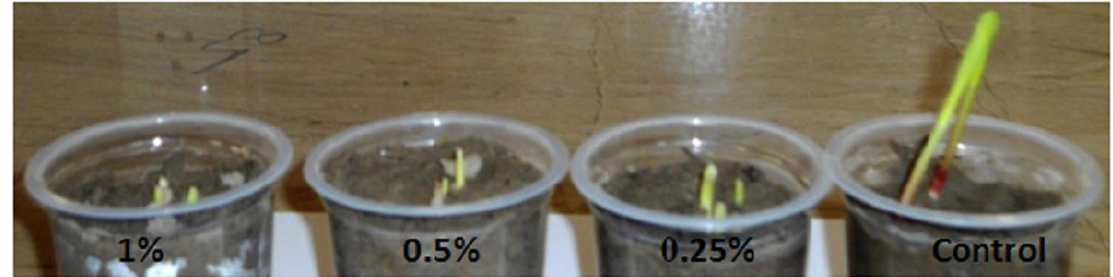
Figure 1. Control vs. various treatments of colchicine (0.25–1%) in growth of interspecific maize × teosinte seedlings after treatment of seeds for 24 h (Niazi, I.A.K., permission granted)